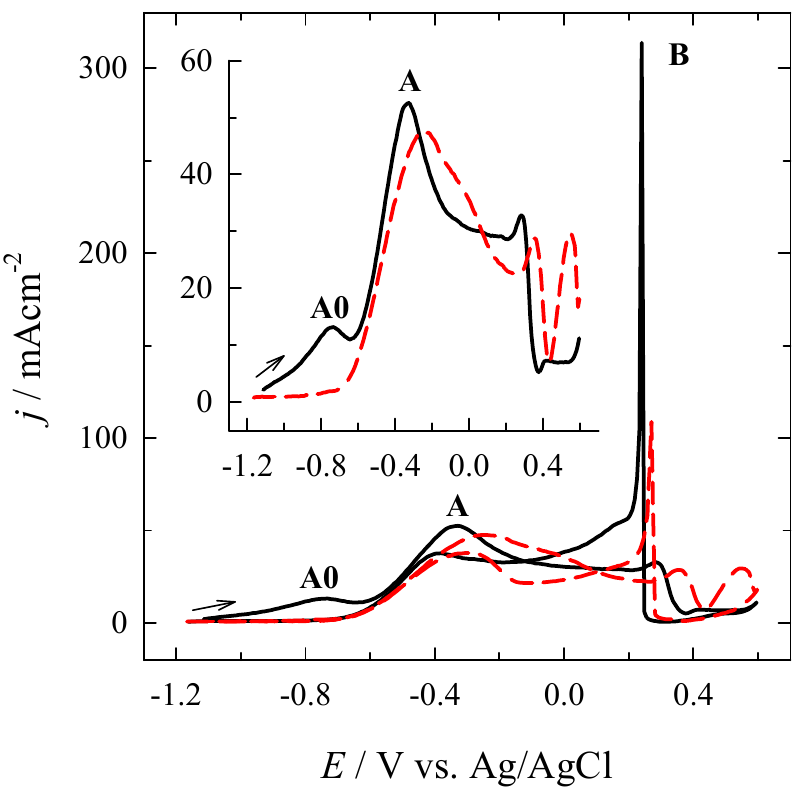
Figure 12. The CVs were recorded on the AuNi-TiO 2 ntb catalyst (15.7 μ g Au ·cm − 2 ) in a 0.05 M NaBH 4 + 1 M NaOH solution at 25 °C at 10 mV·s − 1 . First cycle (solid line) and the one after six hours of subsequent cycling (dashed line).